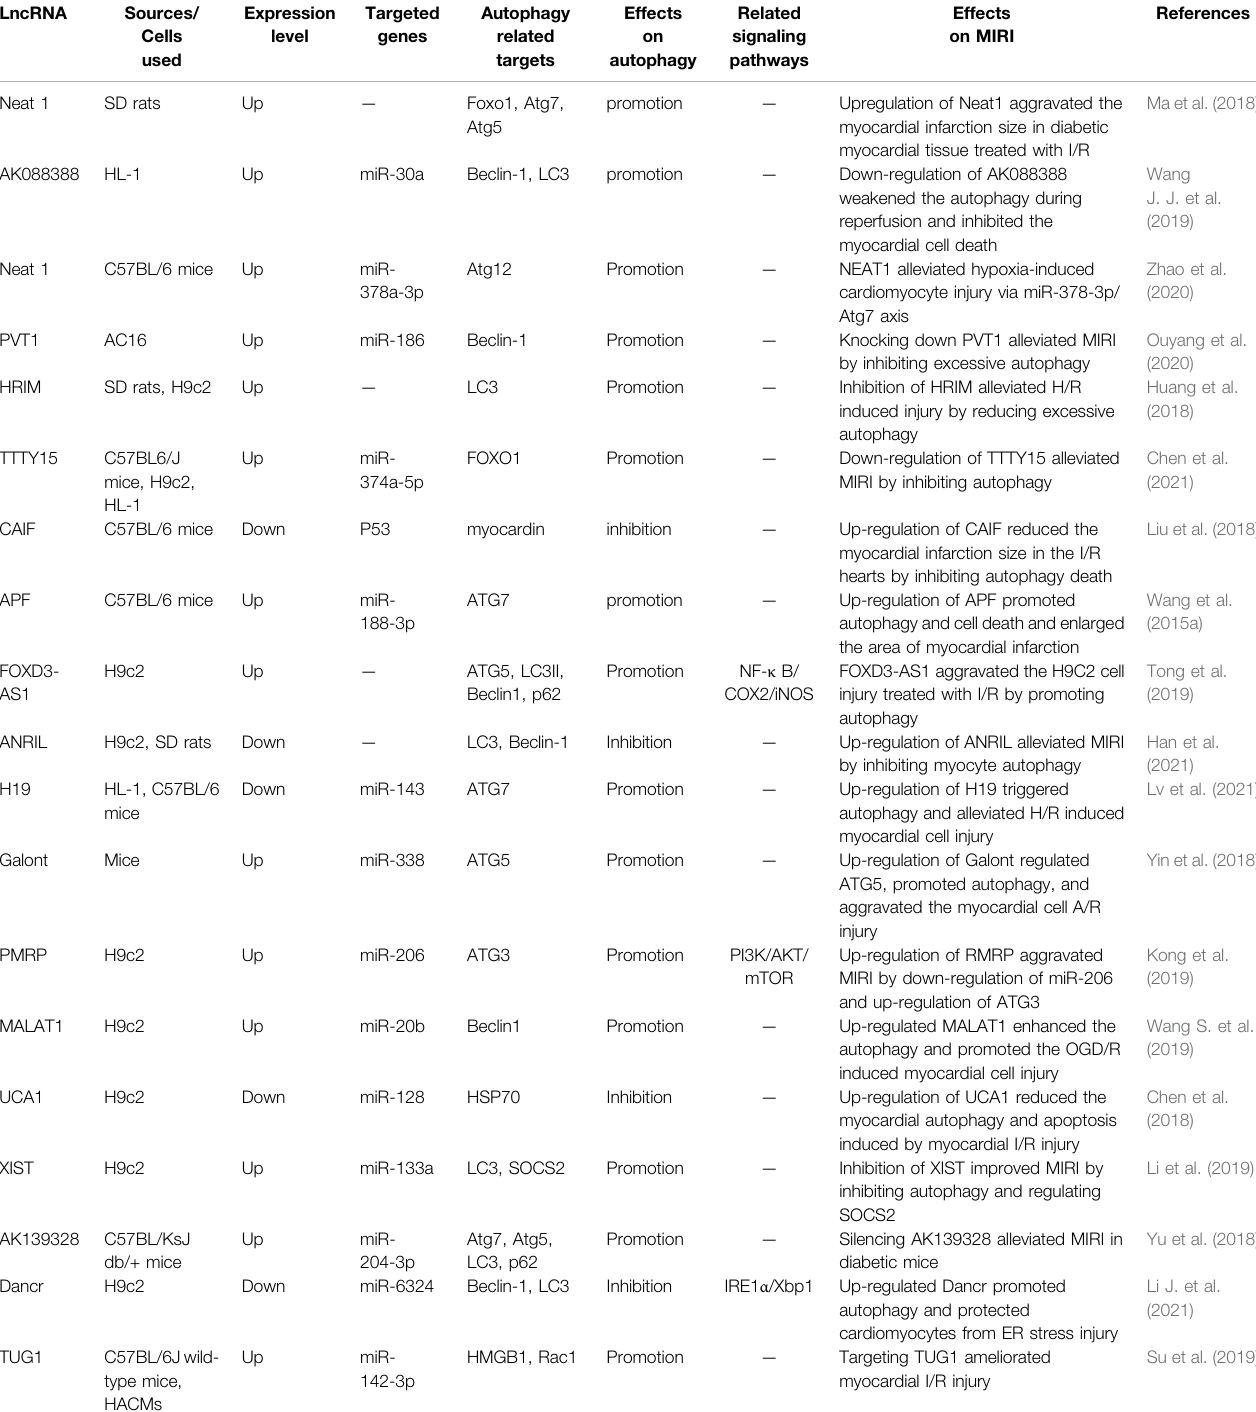
TABLE 2 | The regulatory role of lncRNA in autophagy in the myocardial ischemia-reperfusion injury.